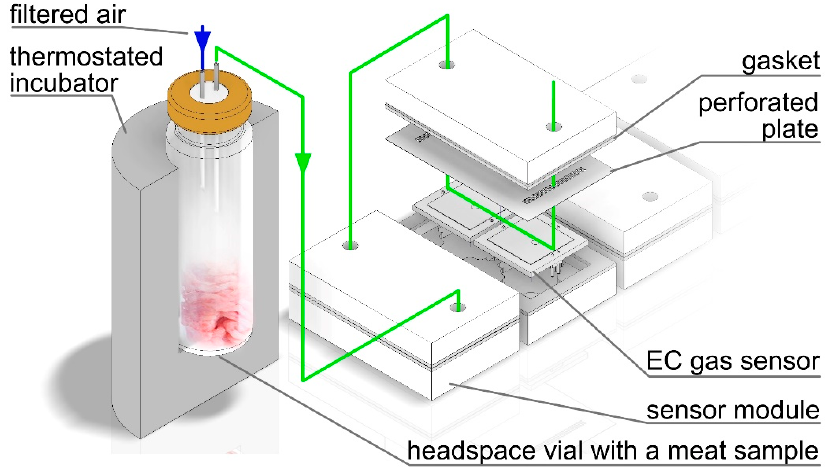
Figure 1. A schematic representation of the sampling with an exploded view of a single sensor module containing two electrochemical gas sensors and a perforated plate to stabilize the gas